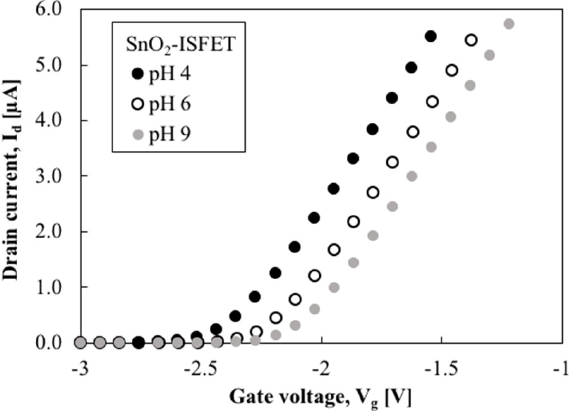
Figure 6. I d –V g of SnO 2 -gate FET in various pH solutions.